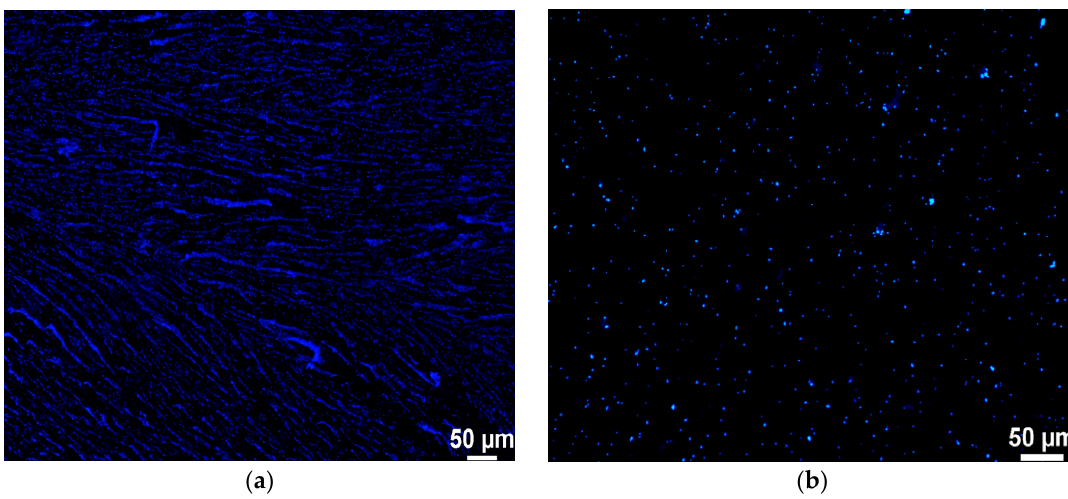
Figure A2. Staphylococcus pseudintermedius stained with 4`,6-diamidino-2-phenylindole (DAPI): Cultivation with a medium flow of ( a ) 21 mL·h − 1 (10.5 mL every 30 min) and ( b ) 16 mL·h − 1 (4 mL every 15 min).